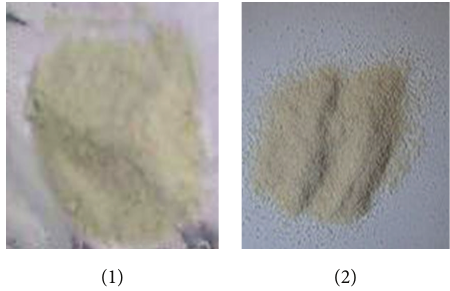
Figure 2: Agave americana leaves powder (1) and inulin (2).